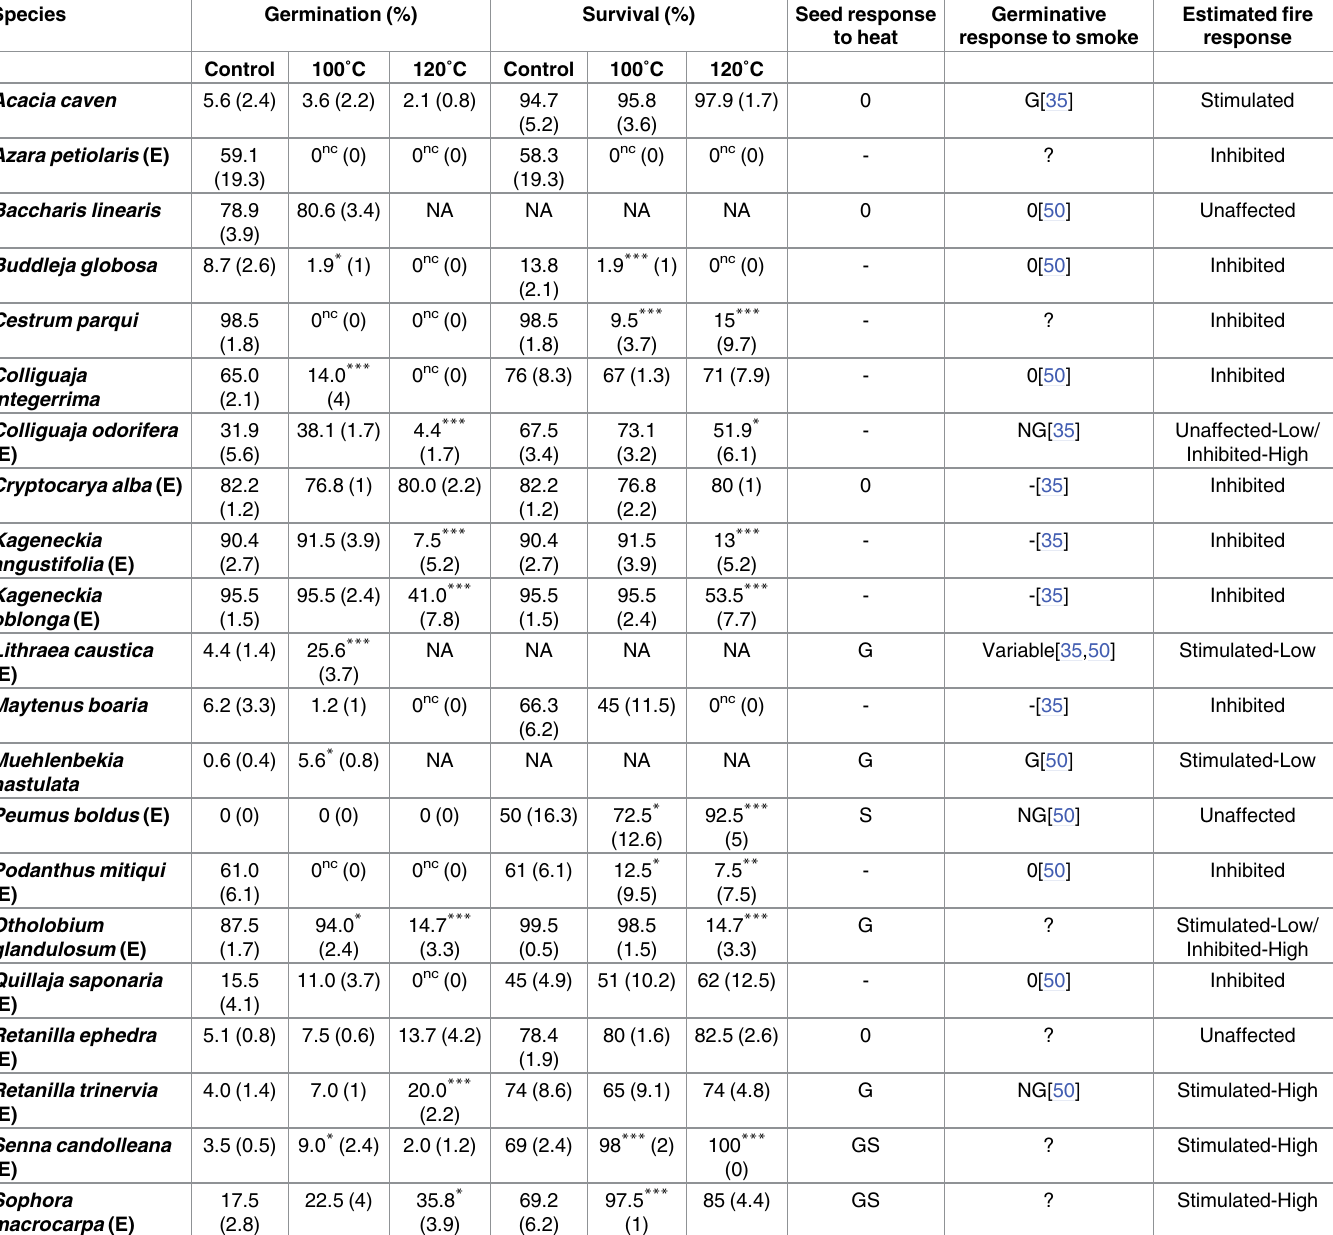
Table 2. Effect of heat shock treatments (100˚Cand 120˚C)on the percentage of seed germination and seed survival of 21 common woody species from the Chilean matorral.